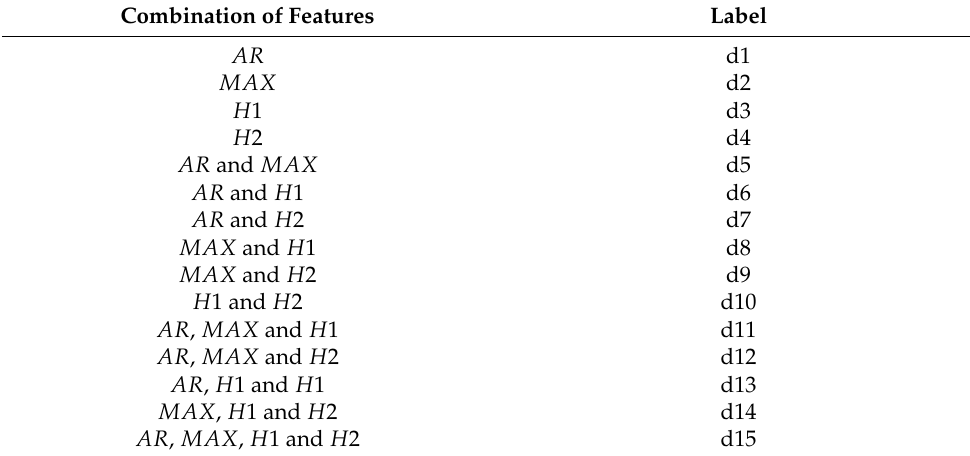
Table 2. Labels for the combination of features: area under the curve ( AR ), maximum value ( MAX ), magnitude value in the ascending part at 2/3 of the time needed to reach the maximum ( H 1) and magnitude value at 1/3 of the same time after the maximum was reached ( H 2).